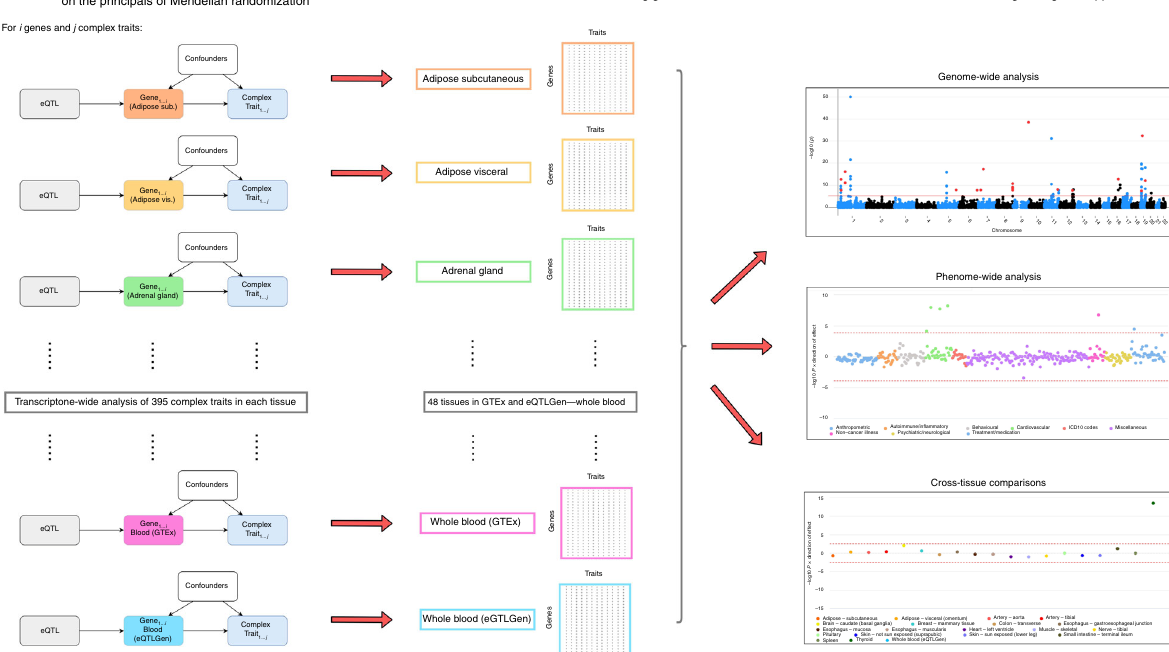
Fig. 1 A schematic of the analysis plan in this study. An overview of the analysis pipeline applied in this study to assess the association between genetically predicted gene expression derived from 48 tissue types with 395 complex traits and